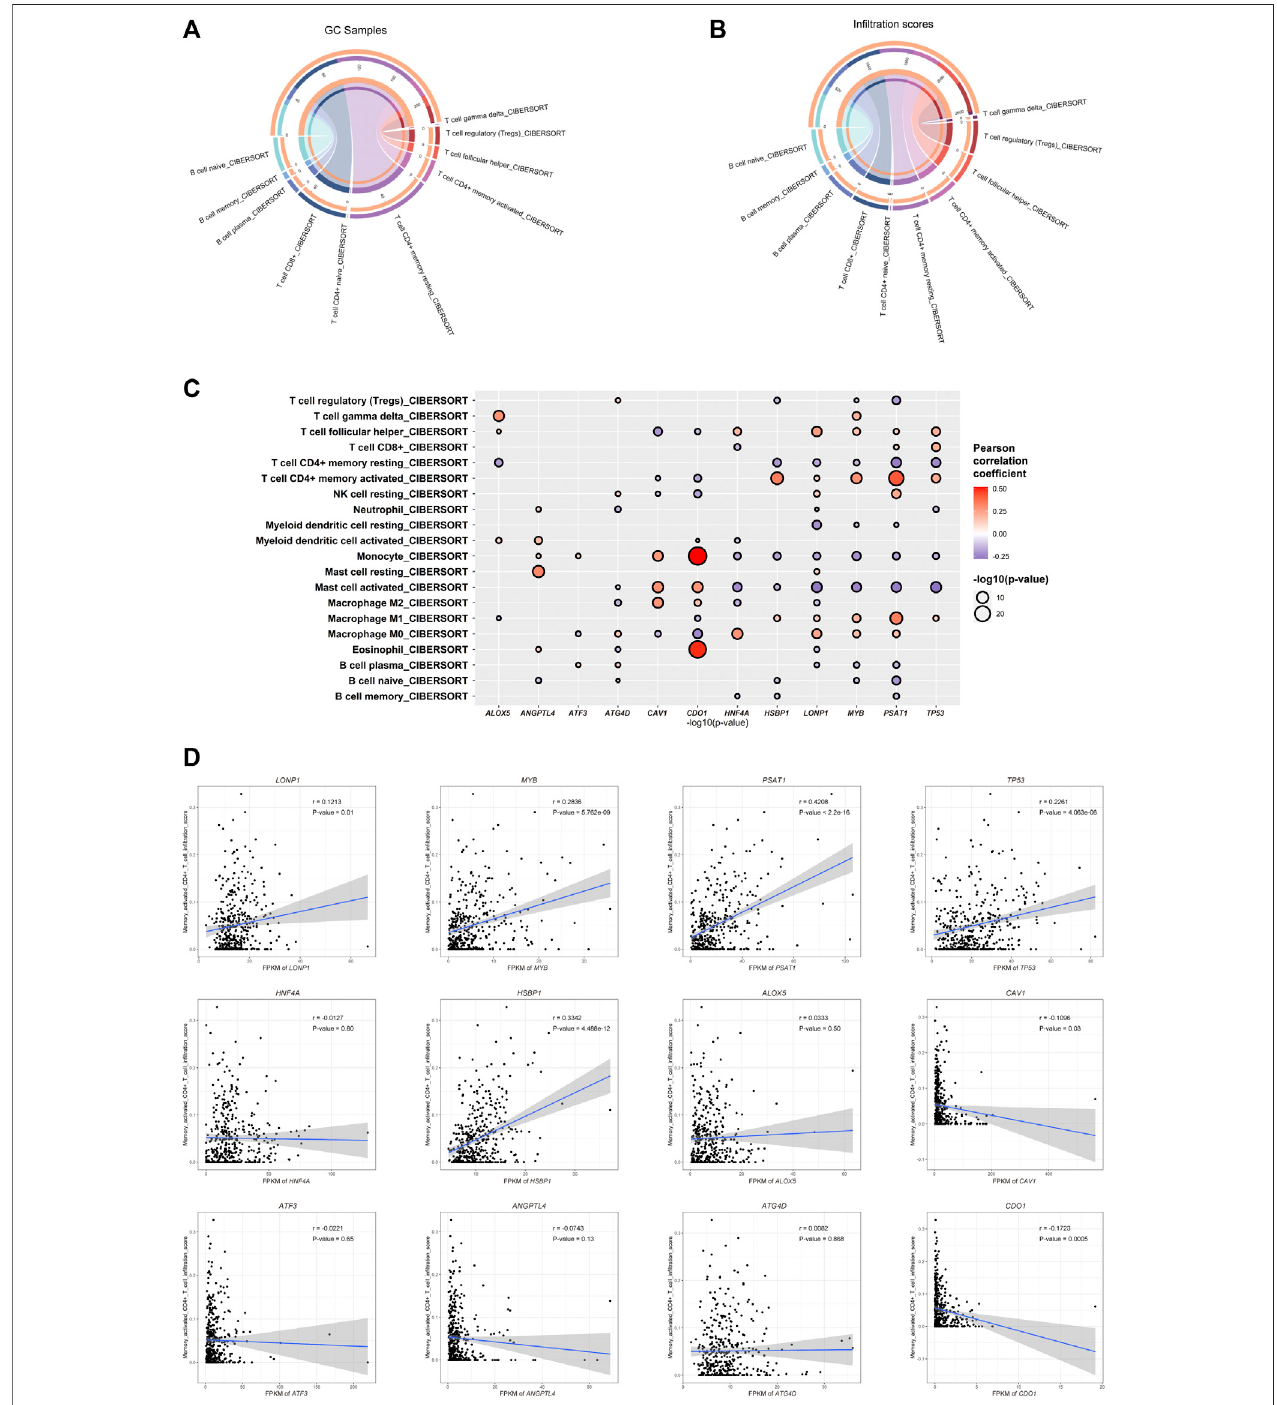
FIGURE4| Ferroptosis-relatedgenesarerelated toimmunecellin fi ltration. (A) Countsofeachin fi ltratedimmunecelltypeinGC. (B) Totalin fi ltratedscoresofeach in fi ltrated immune cell type in GC. (C) Correlation between the in fi ltration scores of each immune cell type and the expression of GC-differentially expressed and prognosis-related FRGs. (D) Dot plot showing the positive correlation between the hub FRGs ( MYB , LONP1 , TP53 , and PSAT1 ) and in fi ltration scores of CD4 + T cells.